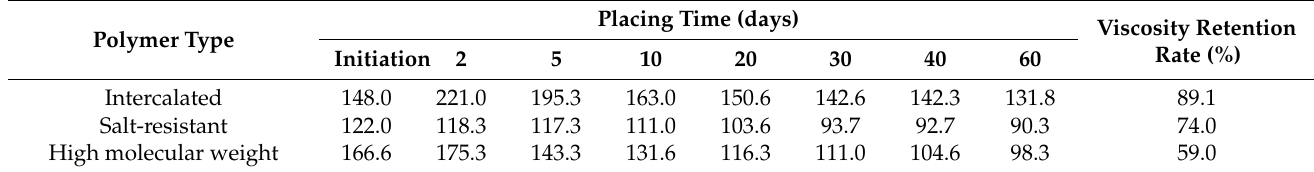
Table 3. Thermal stability of the intercalated